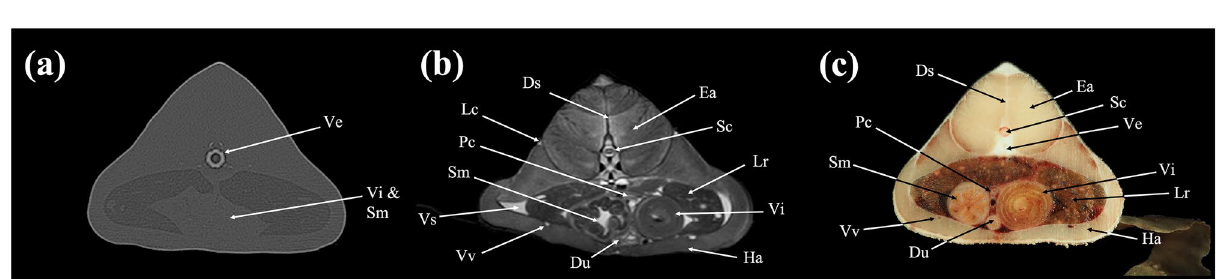
Figure 8. Transverse ( a ) CT, ( b ) MR, and ( c ) cryosection images of a banded houndshark ( Triakis scyllium ) at level 8 of Fig. 25. Ds Dorsal median septum, Du Duodenum, Ea Epaxial, Ha Hypaxial, Id Inclinator dorsalis, Kd Kidney, Lc Lateral line canal, Lr Liver, Pc Pancreas, Pf Pectoral fin, Rc Radial cartilage, Sc Spinal cord, Sm Stomach, Ve Vertebra, Vi Valvular intestine, Vs Visceral cavity, Vv Ventral abdominal vein.